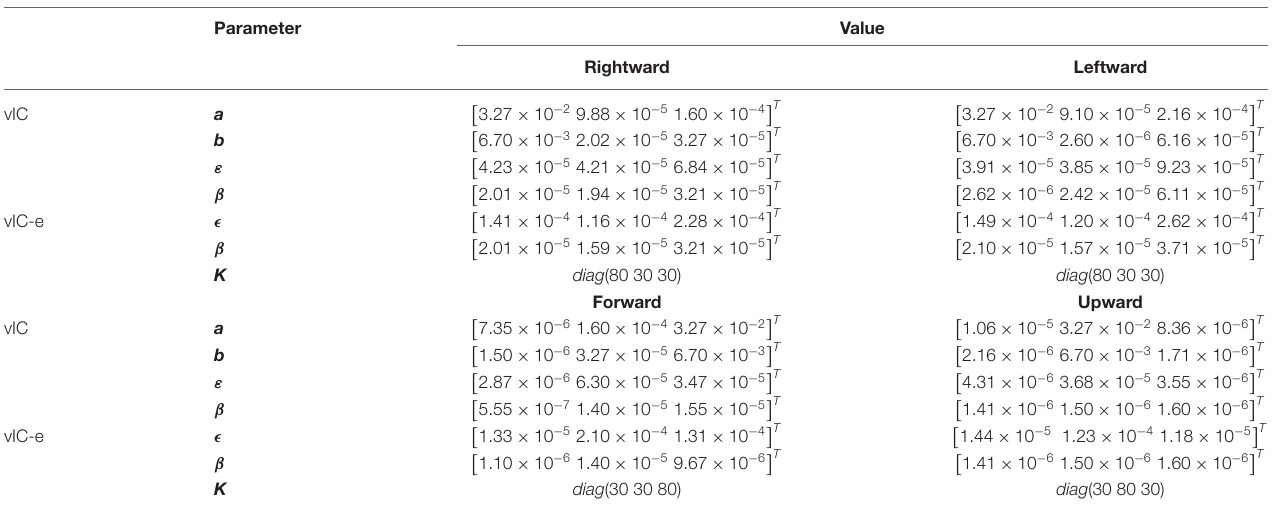
TABLE 2 | Parameters of the experiments.